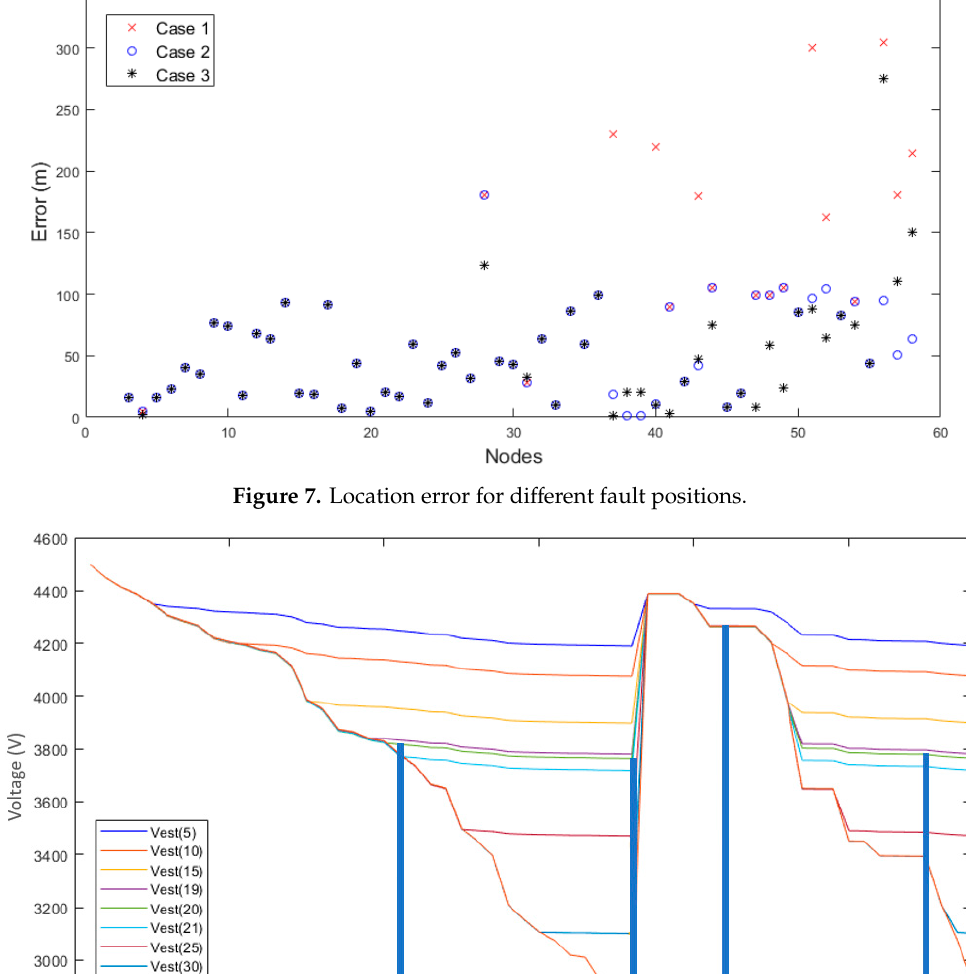
Figure 7. Location error for different fault positions.